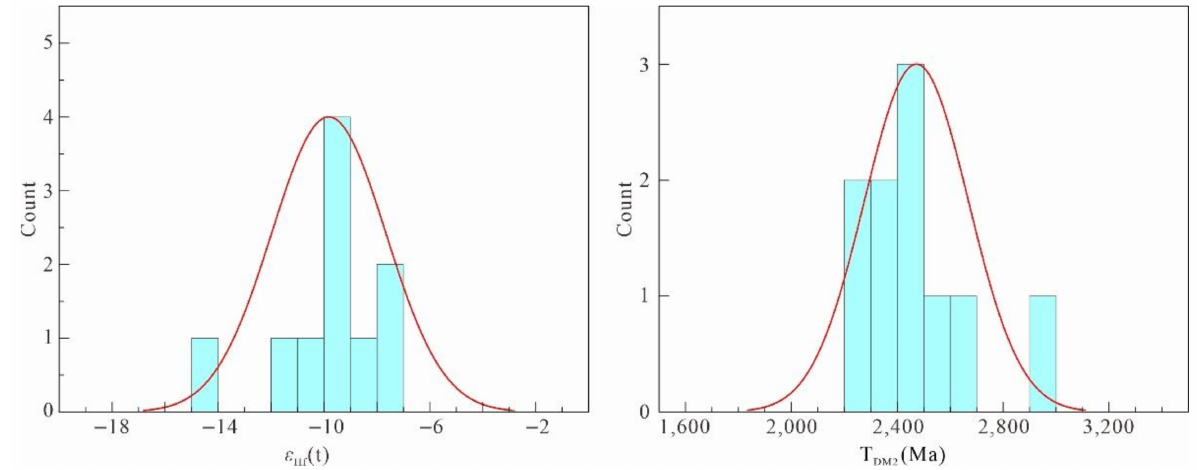
Figure 11. ε Hf (t) and T DM2 distribution histograms of zircons from LG.